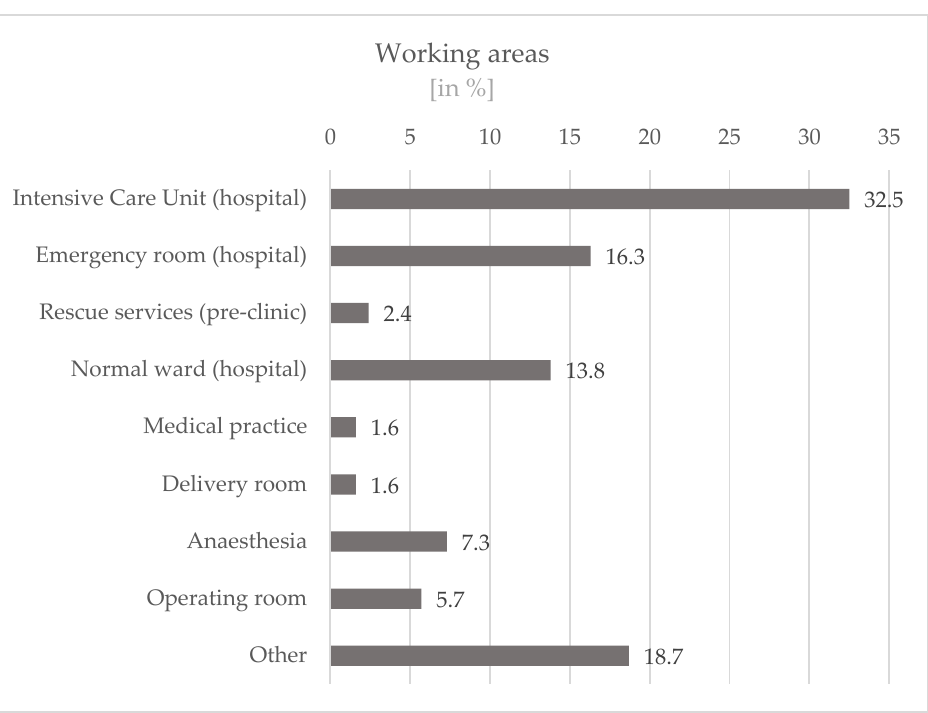
Figure 3. Working areas of the participants.